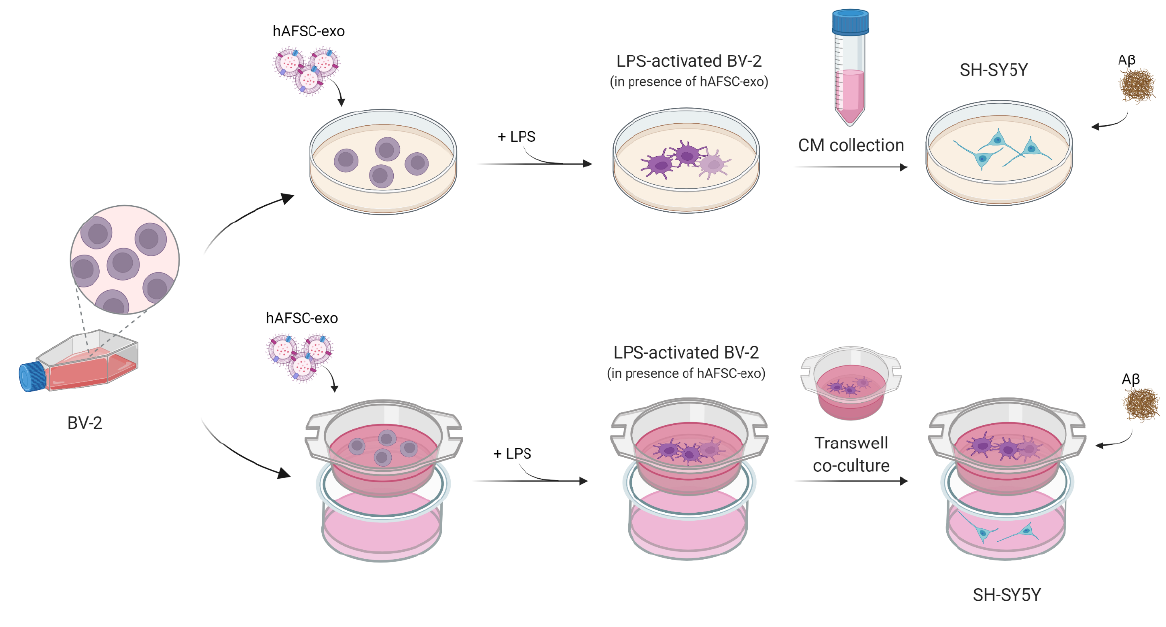
Figure 3. Diagram of experimental design. SH-SY5Y exposed to BV-2 CM or to BV-2 co-culture in presence or absence of A β and exo. Image elaborated with